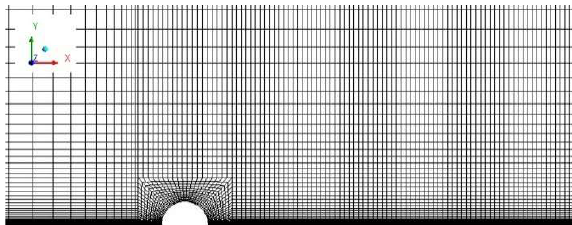
Figure 2. Magnified view of mesh near the obstacle line. ∆ y + = 0.7, ∆ x + = 37 and ∆ z + = 18 at the plate. The mesh is evenly distributed in the streamwise and spanwise directions and becomes dense in the near-wall area in the normal direction. The amount of global mesh is 6.88 million.